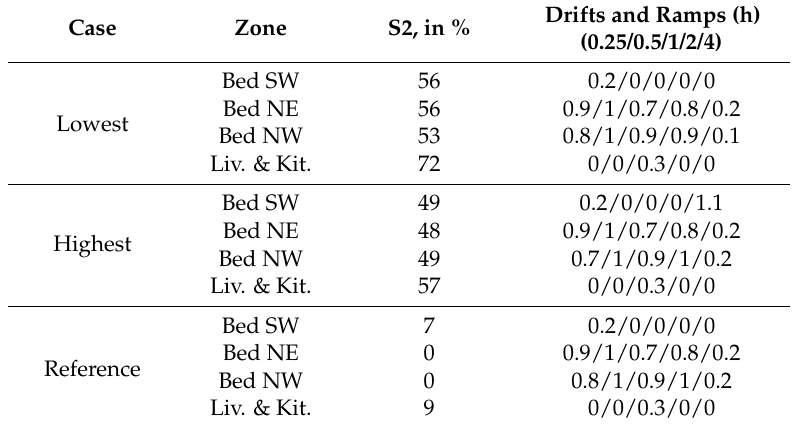
Table 7. The dissatisfaction of the thermal comfort for exemplary zones in the lowest, highest, and reference